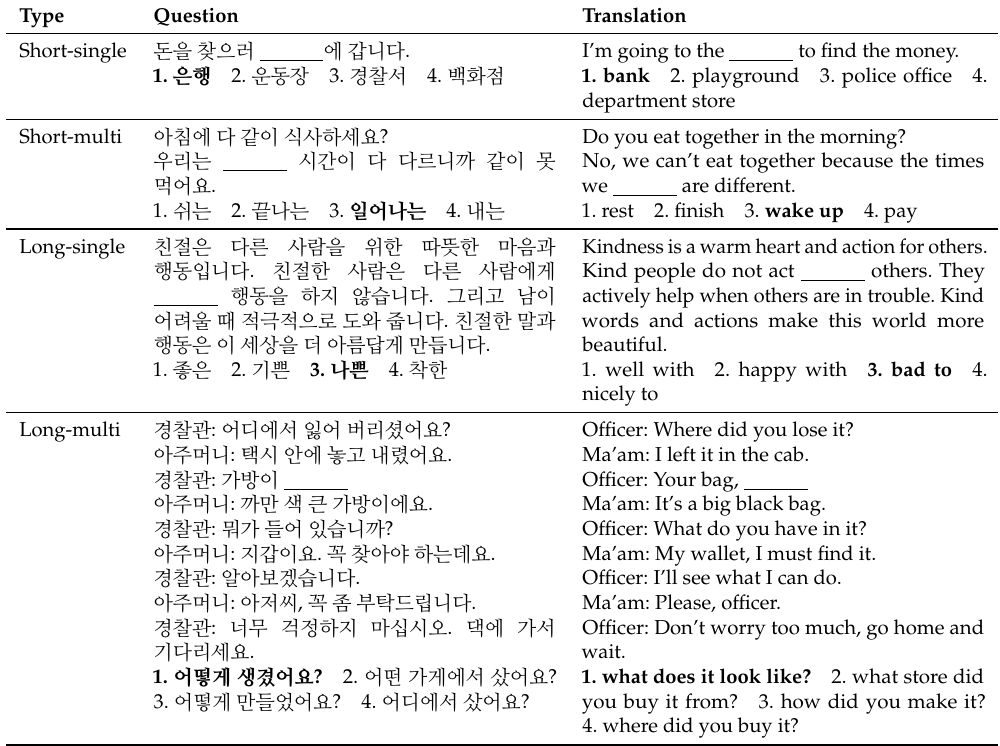
Table 10. Samples from the TOPIK